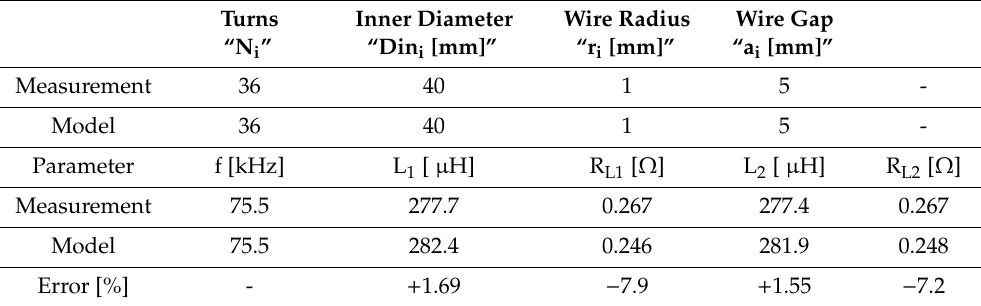
Table 3. Geometry parameters of Shielded Coils for model verification.